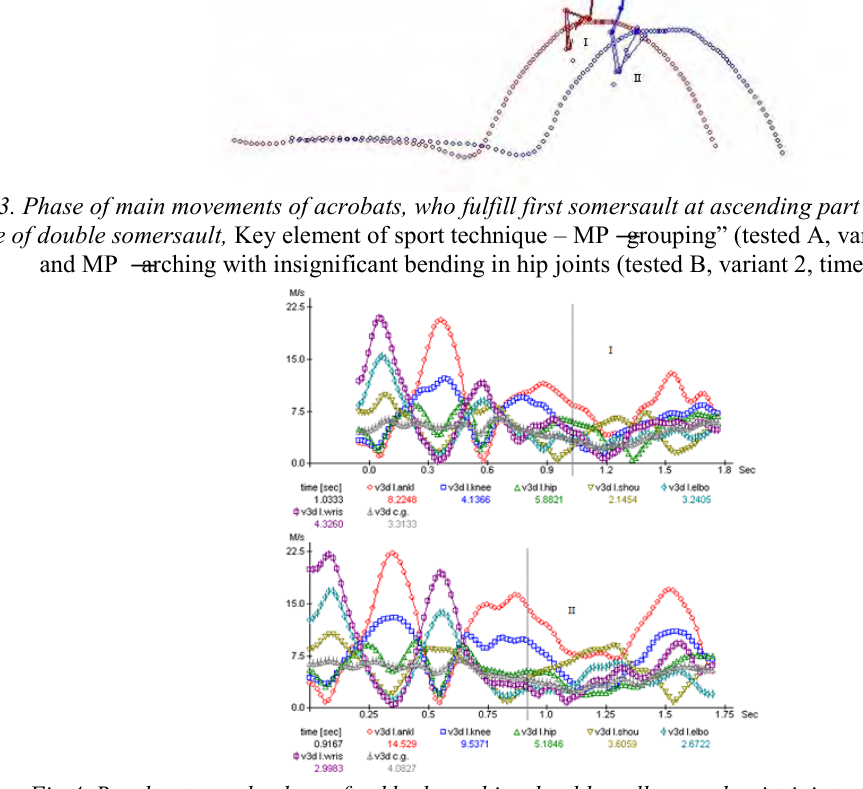
Fig.4. Resultant speed values of ankle, knee, hip, shoulder, elbow and wrist joints, GMC in phase of main movements; MP in grouped back double somersault after rondat (tested A, upper section of figure, time – 1. 033sec.)and arched back double somersault after rondat – back turnover (tested B, lower section of figure, variant 2, time - 0.